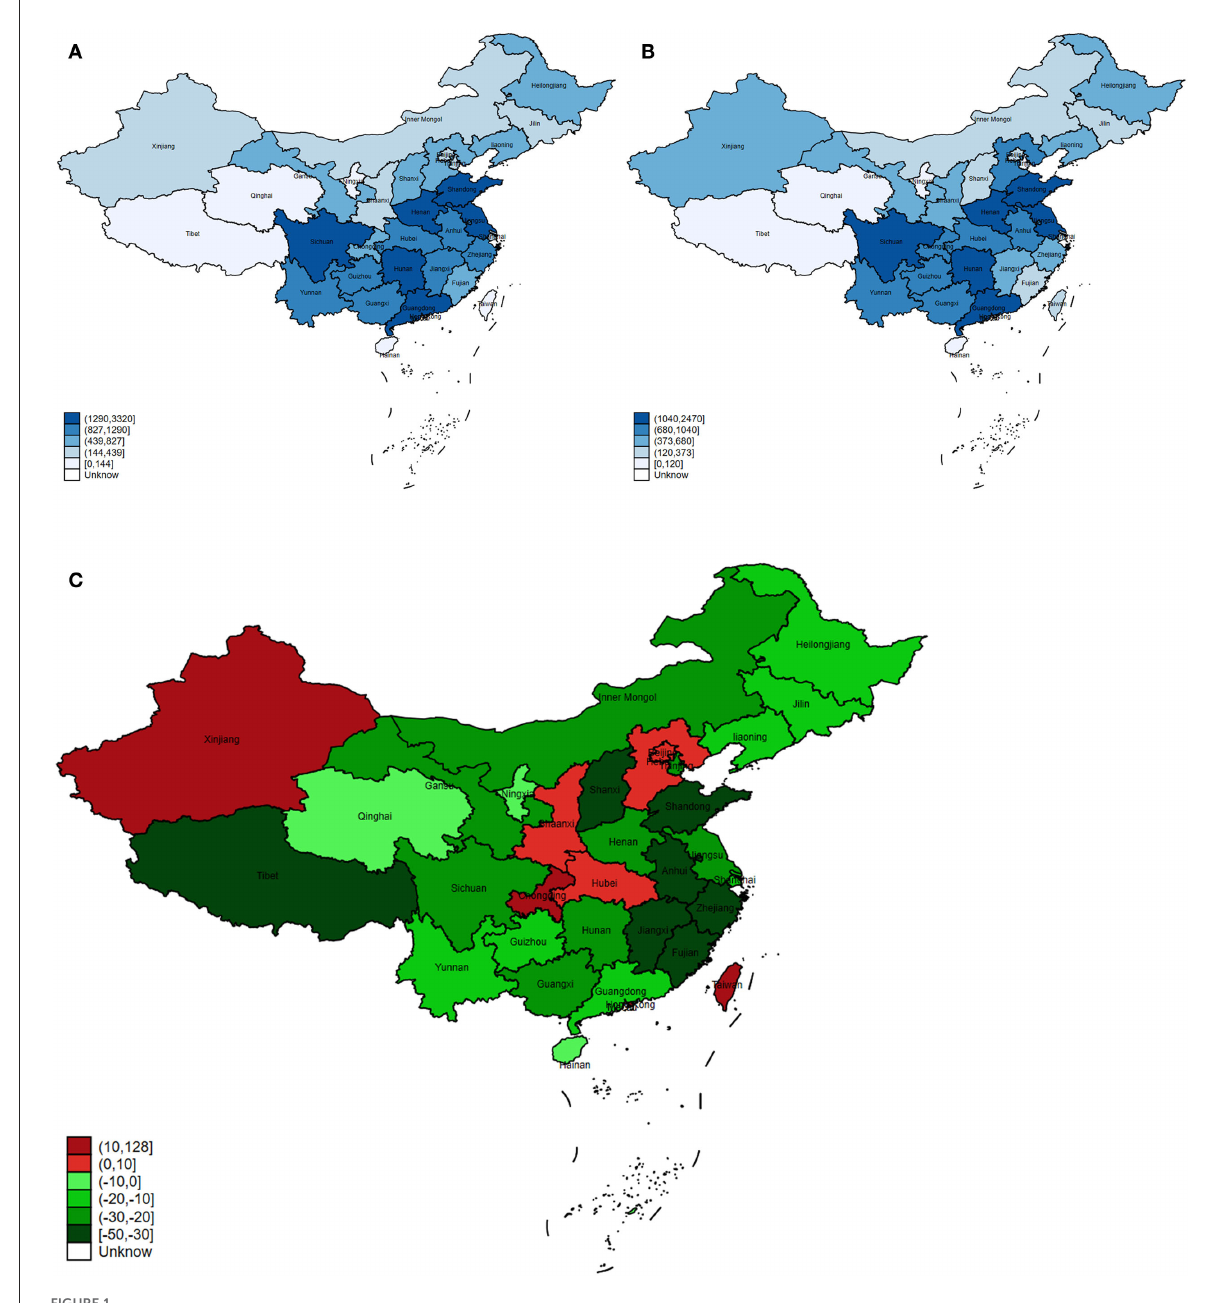
FIGURE1 The trend of COPD DALY in China and its provinces. (A) The DALYs in China and its provinces in 1990. (B) The DALYs in China and its provinces in 2017. (C) The change of DALY cases in China and its provinces from 1990 to 2017.